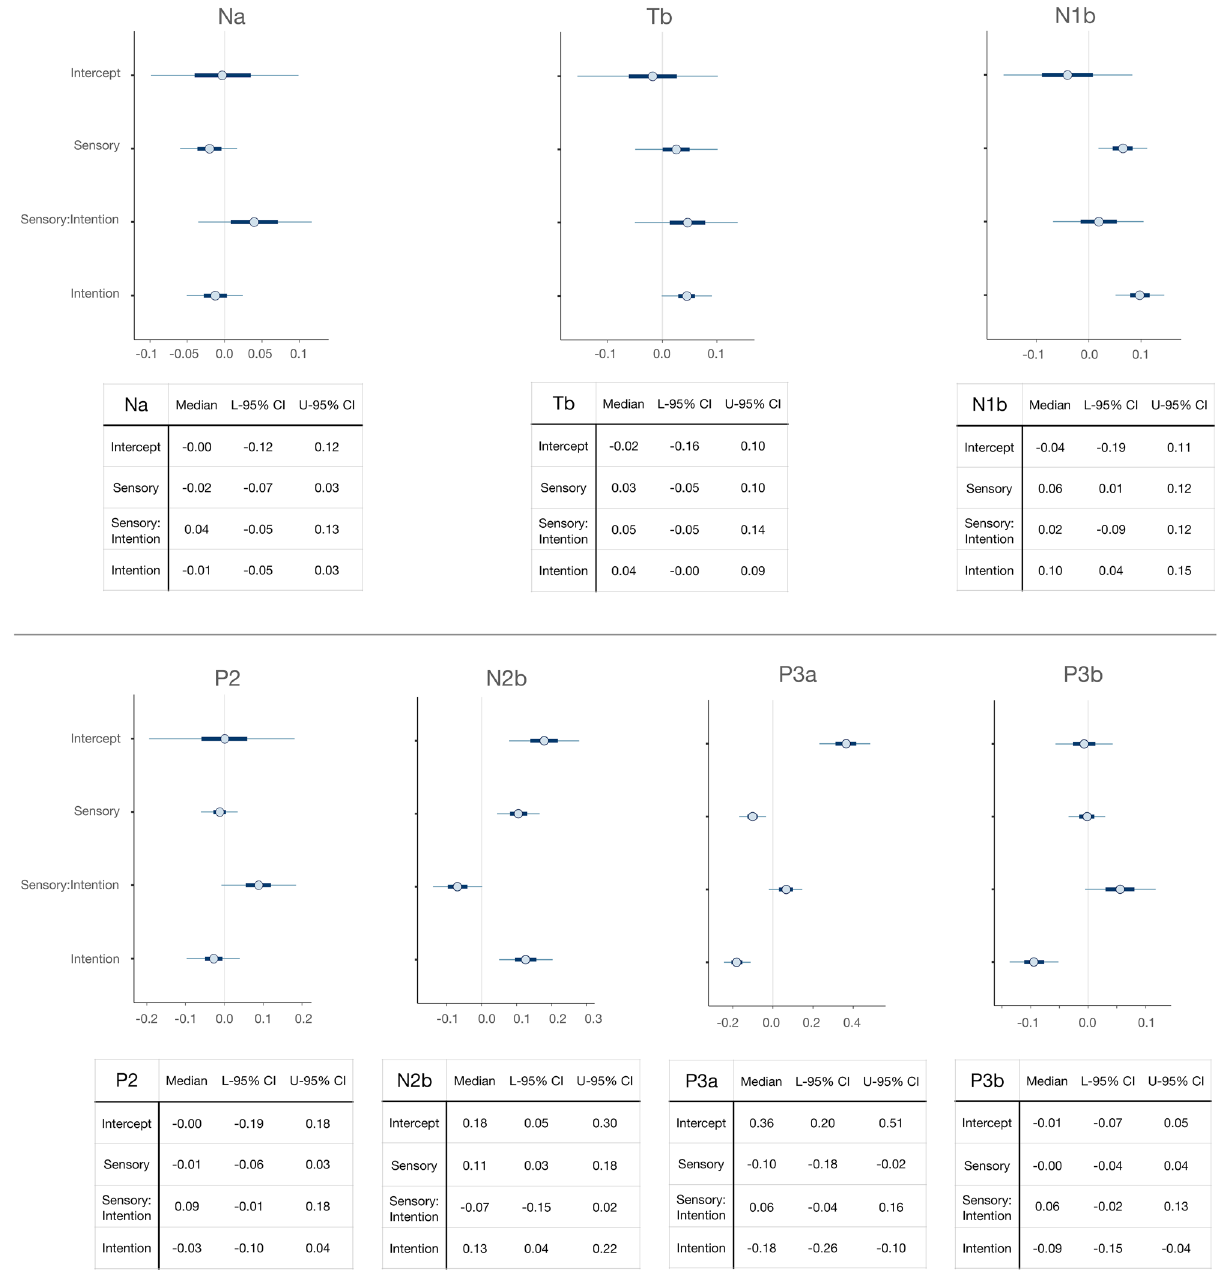
Figure 5. Medians and credible intervals (On the plots: 50%, thick line; 90% thin line. On the tables: 95%) of parameter values in Na, Tb, N1b, P2, N2b, P3a, and P3b. Intervals that do not include zero have the denoted probability to be a true